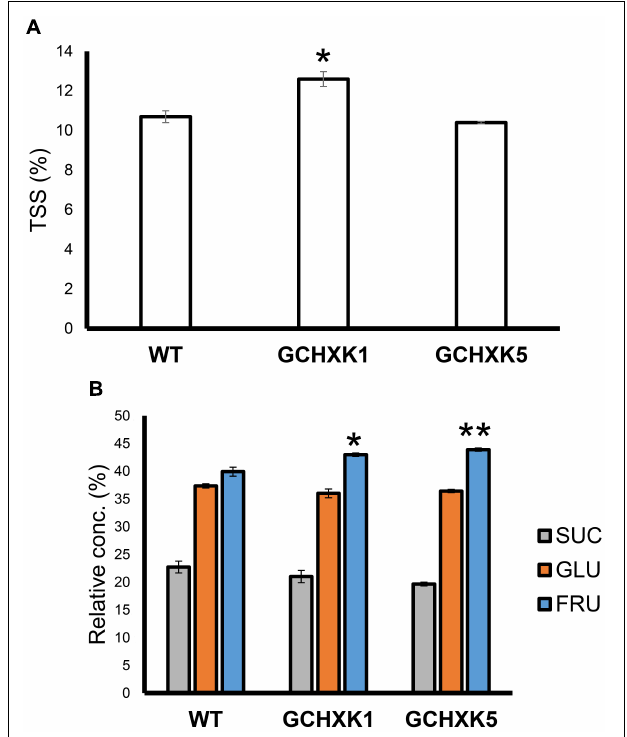
FIGURE 10 | TSS content and sugar content of GCHXK fruit. (A) TSS levels in the juices of GCHXK lines, compared to the WT. (B) Relative sucrose, fructose, and glucose levels (from total sugar content) in the juice of GCHXK lines, compared to the WT. Each measurement included three samples. For the WT and GCHXK1, the juice of each sample was collected from two different fruits. For GCHXK5, the juice of each sample was collected from one fruit (due to a lack of fruits). Data are displayed as means ± SE. Asterisks denote significant differences relative to the WT ( t -test, * P < 0.05; ** P < 0.01). apple (Blanke and Lenz, 1989). It has also been